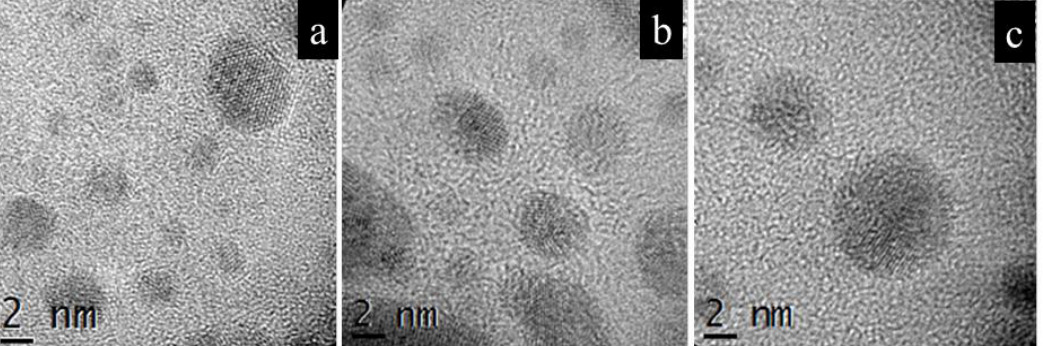
Fig. 5. Ag Nanoparticles for the different plant sections at pH10, (a) leaves, (b) stems and (c) roots